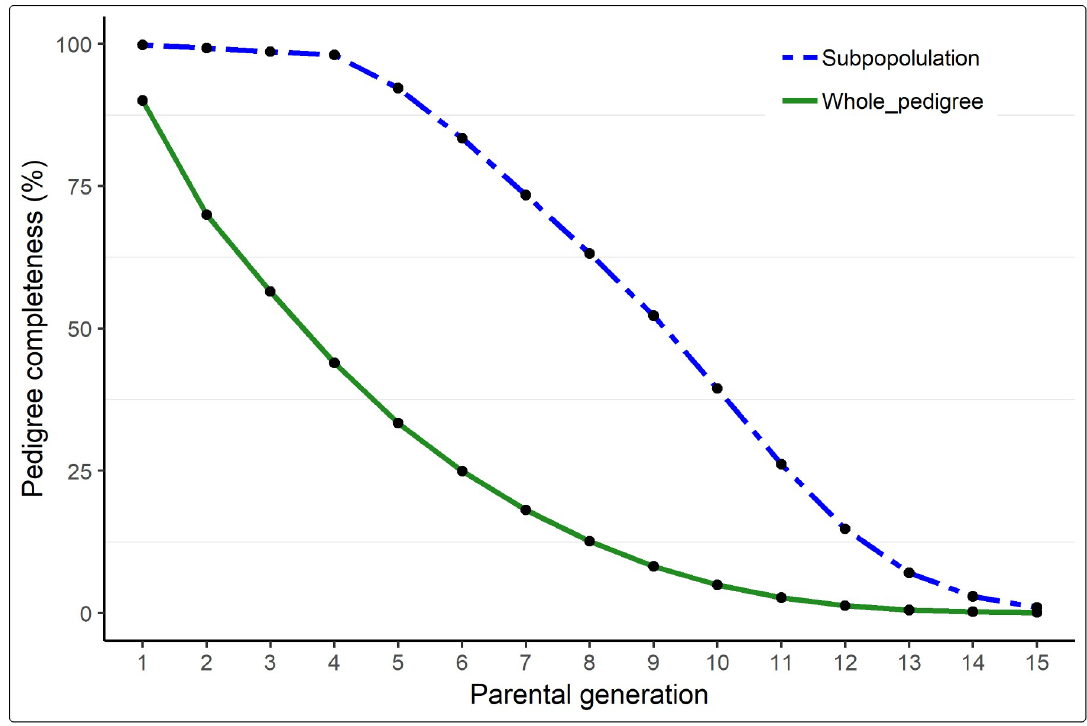
Fig 1. Pedigree completeness per parental generation computed for the entire German White-headed mutton pedigree (green) and for the reference subpopulation (blue). Parental generation 1 represents parents, 2 represents grandparents, etc. Animals were born between 1970 and 2015.